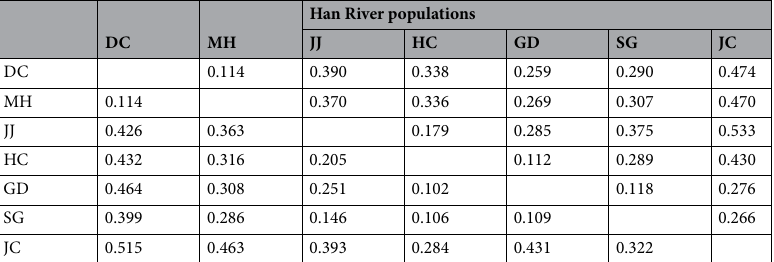
Table 2. Pairwise microsatellite genetic differentiation of seven Rhodeus pseudosericeus populations from the Korean Peninsula. Estimates of F ST appear above the diagonal and estimates of R ST appear below the diagonal. All comparisons were significantly different from zero ( P <